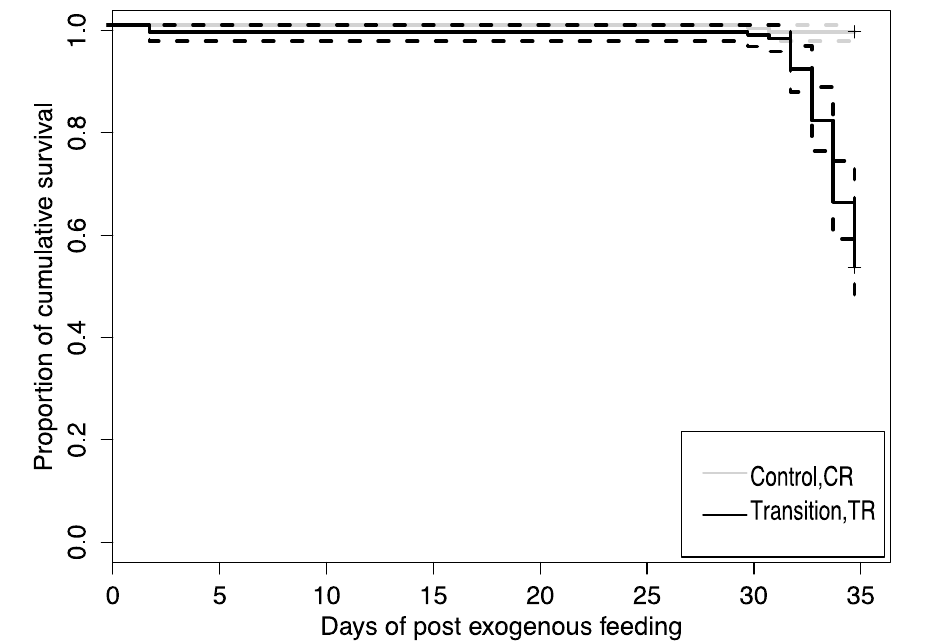
Figure 1. Mean cumulative survival (%; solid line) of lake sturgeon larvae from transition (TR) and control (CR) treatments with 95% CI (dashed line). Survival analyses were based on log-rank tests indicating that survival of fish in the TR treatment (0.527) was significantly lower compared to fish from the CR treatment (0.987) (chi-square value, χ 2 = 85.1, p -value < 0.01, df = 1).